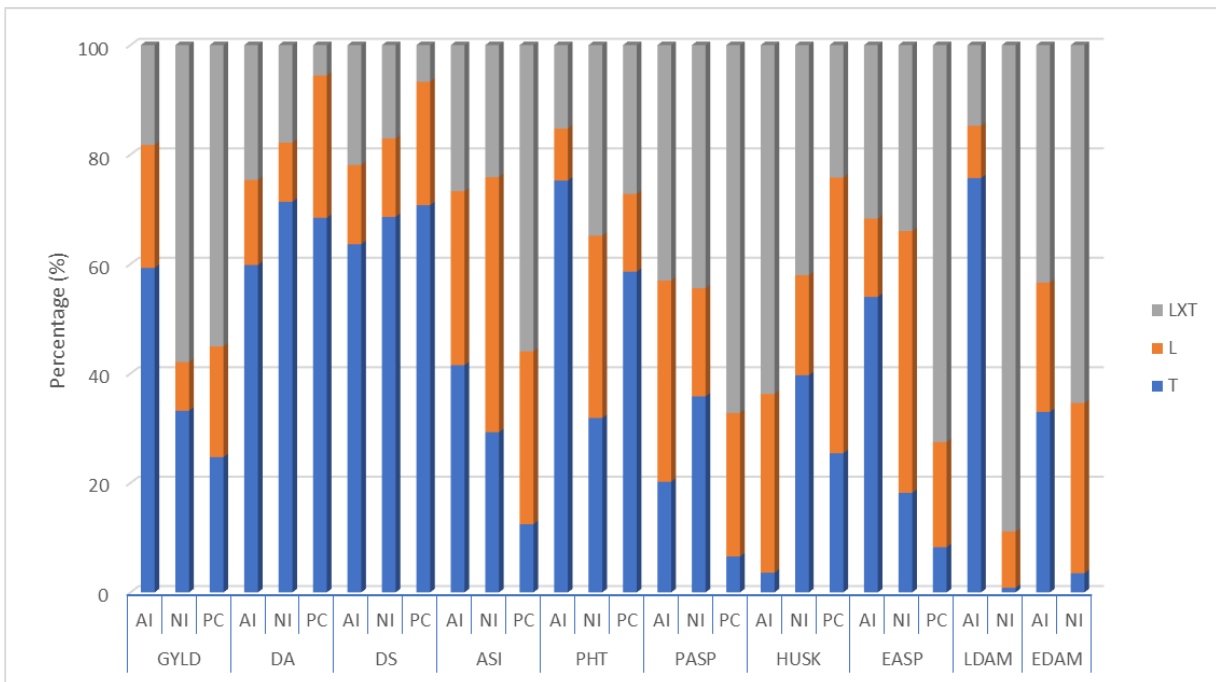
Figure 2. Percentage contributions of testers (T), lines (L) and line x tester (L × T) to the expression of agronomic and fall armyworm-resistance traits of maize hybrids evaluated under infested and protected conditions.